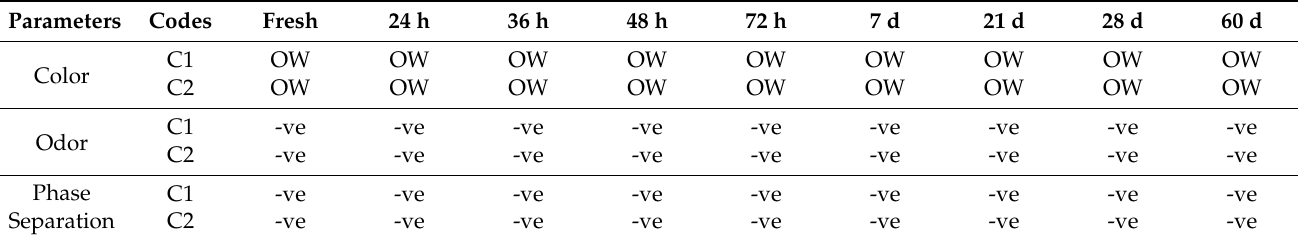
Table 4. Stability study of formulations at different temperatures for 60 days.